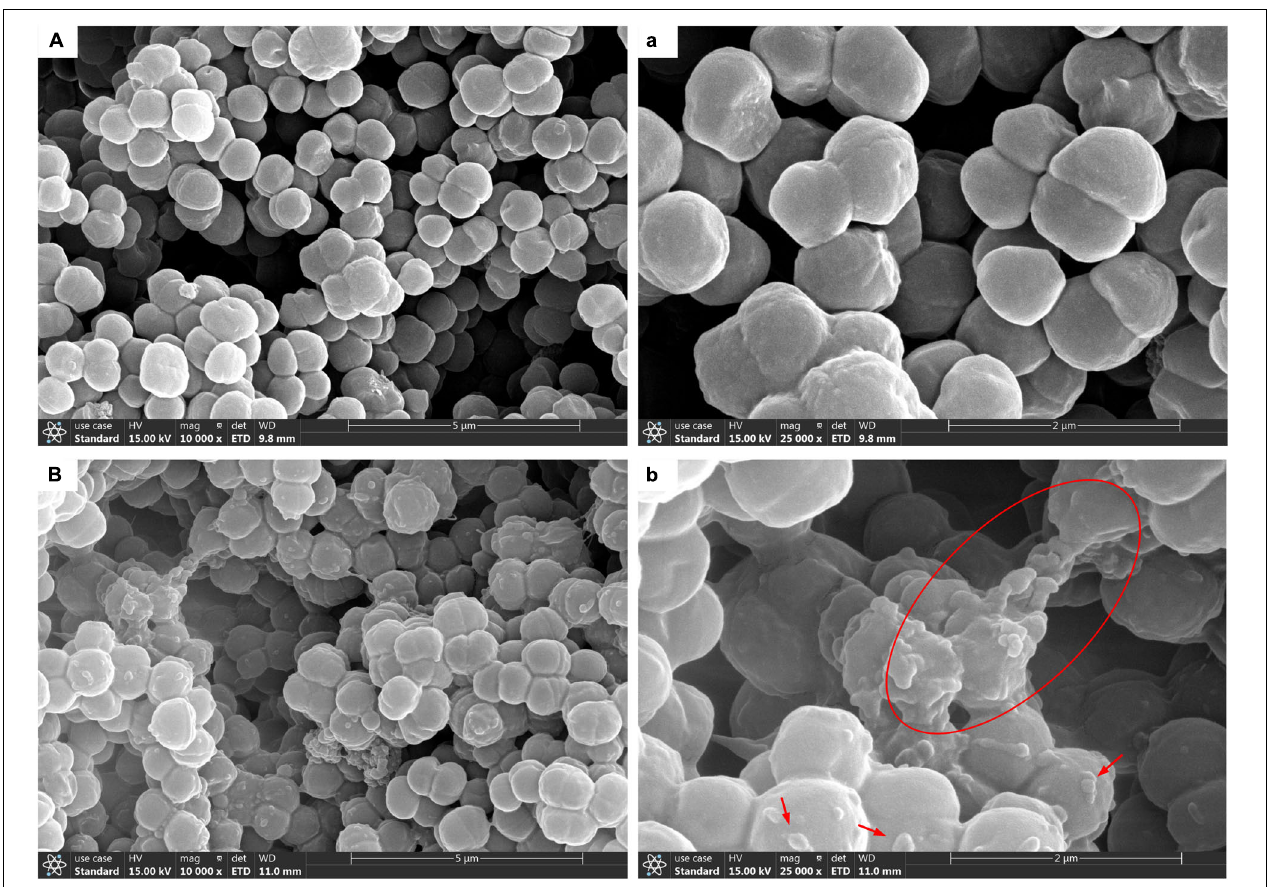
FIGURE 2 | Scanning electron microscopy (SEM) images of T. halophilus biofilms. (A,a) SEM images of planktonic cells taken at × 10,000, × 25,000 magnification, respectively. (B,b) SEM images of biofilms taken at × 10,000, × 25,000 magnification, respectively. The red circle displays the network-like structures, and arrows were surface